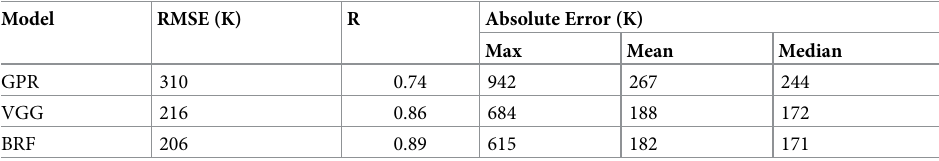
Table 3. Model generalization on spectra of nonuniform